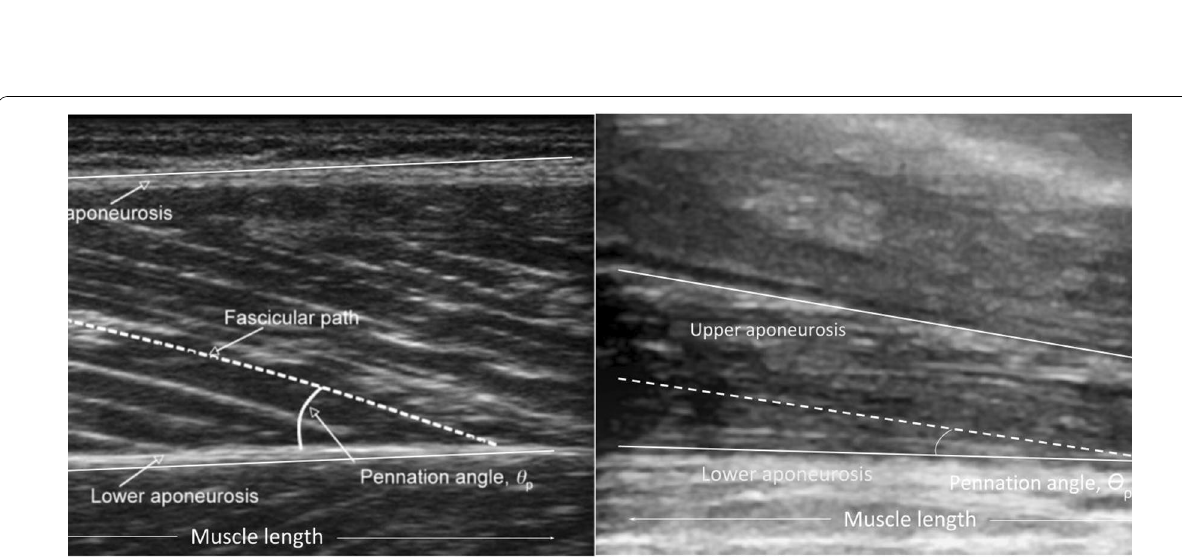
Fig. 5 The muscle ultrasound pennation angle. The figure represents a longitudinal view of quadriceps rectus femoris muscle. The pennation angle is calculated between the intercept of fascicular path to the lower aponeurosis. Additionally, the muscle length can be measured. These two variables may be used to determine the strength of the muscle, as the lower is the angle, the lower is the length, and the lower is the strength. The right panel represents a representative reduction in pennation angle after 1 week of ICU